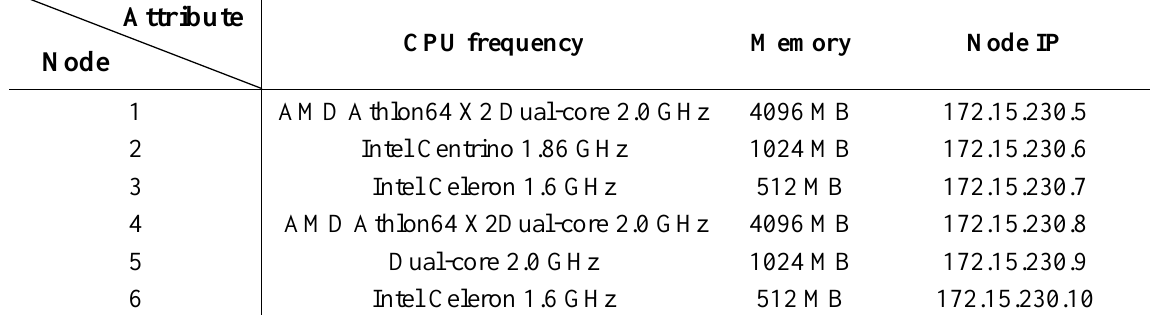
Table 9. The user nodes’ specifications.